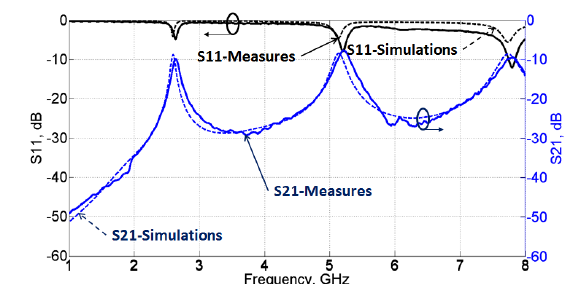
Figure 7: S-parameters from measurements (plain lines) and simulations (dotted lines) in presence of TiO 2 material from 1 GHz to 8 GHz.